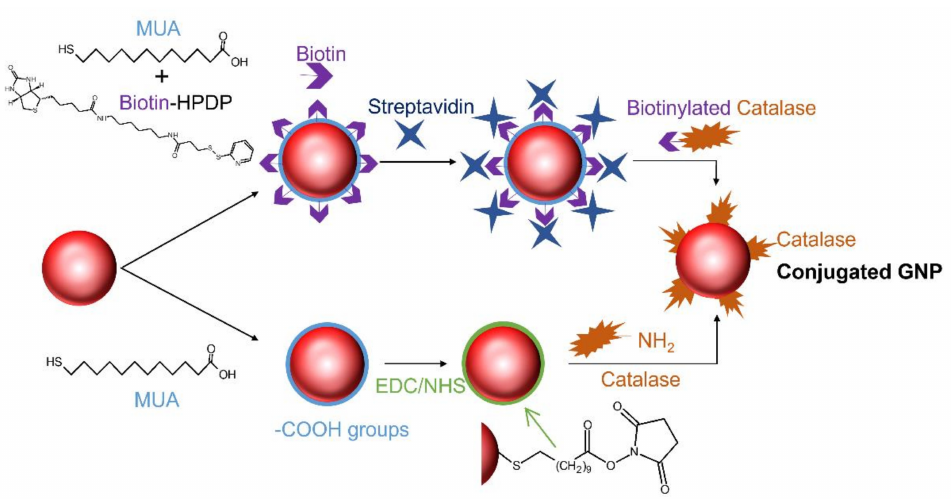
Figure 5. Scheme of two approaches involved in the coupling of protein (catalase) to AuNPs. Reprinted with permission from ref. [72]. Copyright 2011, Elsevier. GNP—gold nanoparticle, MUA—11-mercaptoundecanoic acid, biotin-HPDP- (N-(6-(biotinamido)hexyl)-30-(20-pyridyldi- thio)-propionamide, EDC-N-(3-Dimethylaminopropyl)-N’-ethylcarbodiimide hydrochloride, NHS—